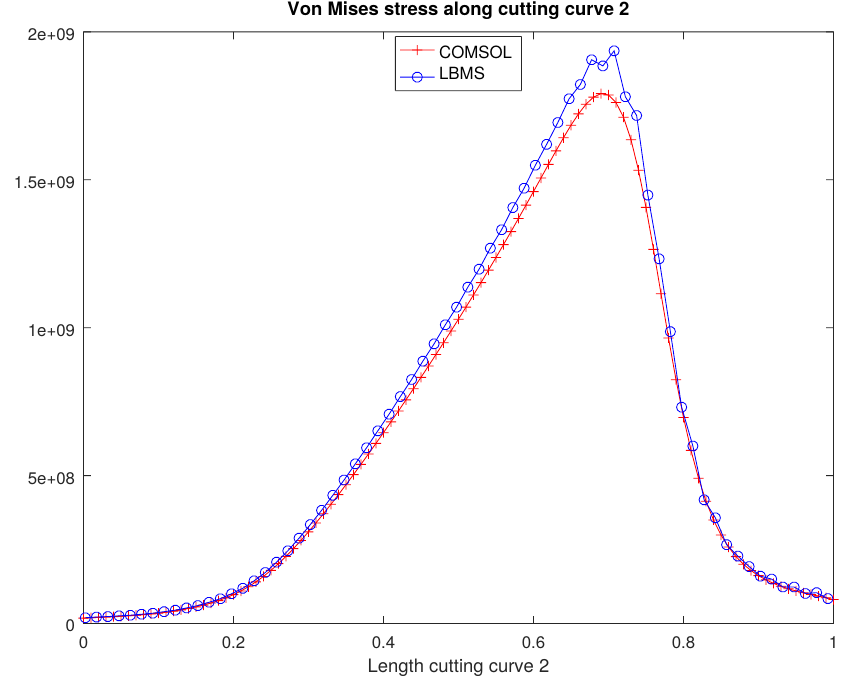
Figure A19. Von Mises stress along cutting curve C 2 for case E = 200 GPa, ν = 0.15 with triangular loading.